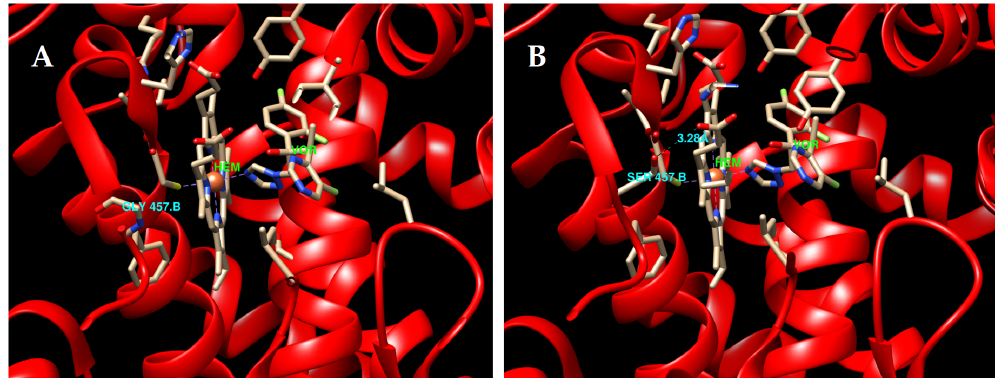
Figure 2. Crystal structure of 14- α sterol demethylase (Cyp51B) from A. fumigatus in complex with voriconazole. ( A ) Structure of WT Cyp51B with the amino acid glycine in position 457. ( B ) Structure of Cyp51B with the substitution of the glycine for a serine in the position 457 of the protein. Hydrogen bonds between serine 457 and heme group are shown as cyan dashes and its length is 3.28 Å. The carbon atoms of the voriconazole and the heme (stick representations) are both in gray and labeled in green (VOR and HEM). The iron is depicted as an orange sphere. The protein backbone is colored in red.